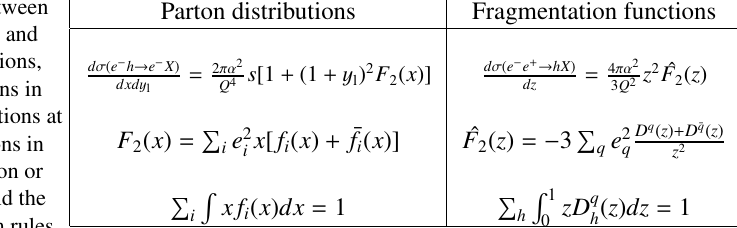
Parton distributions